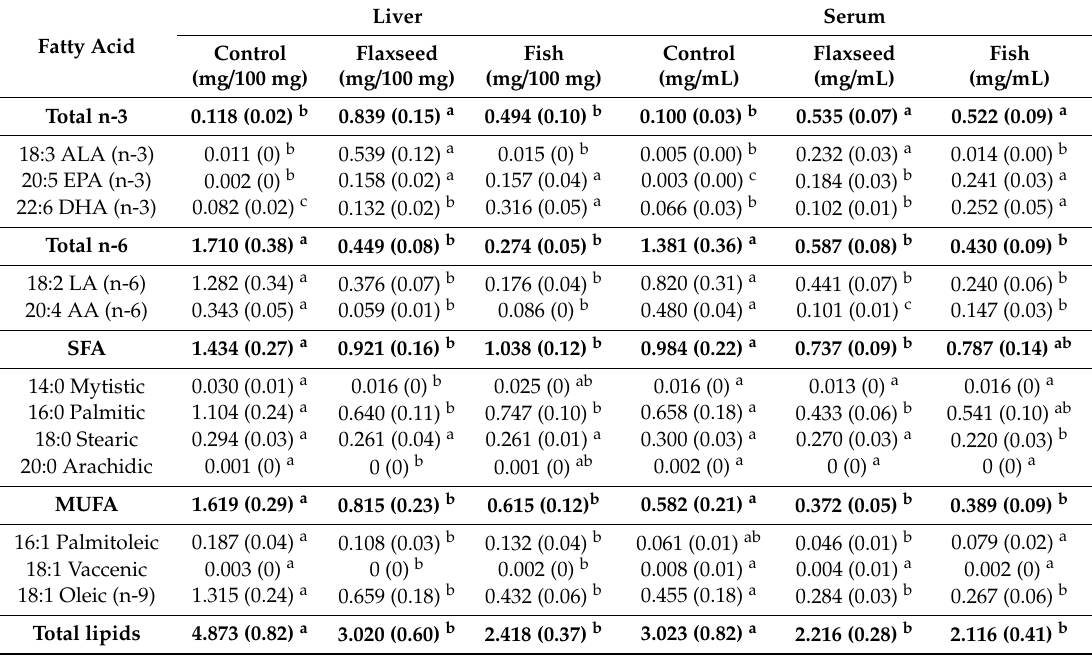
Table 3. Hepatic and serum FAs